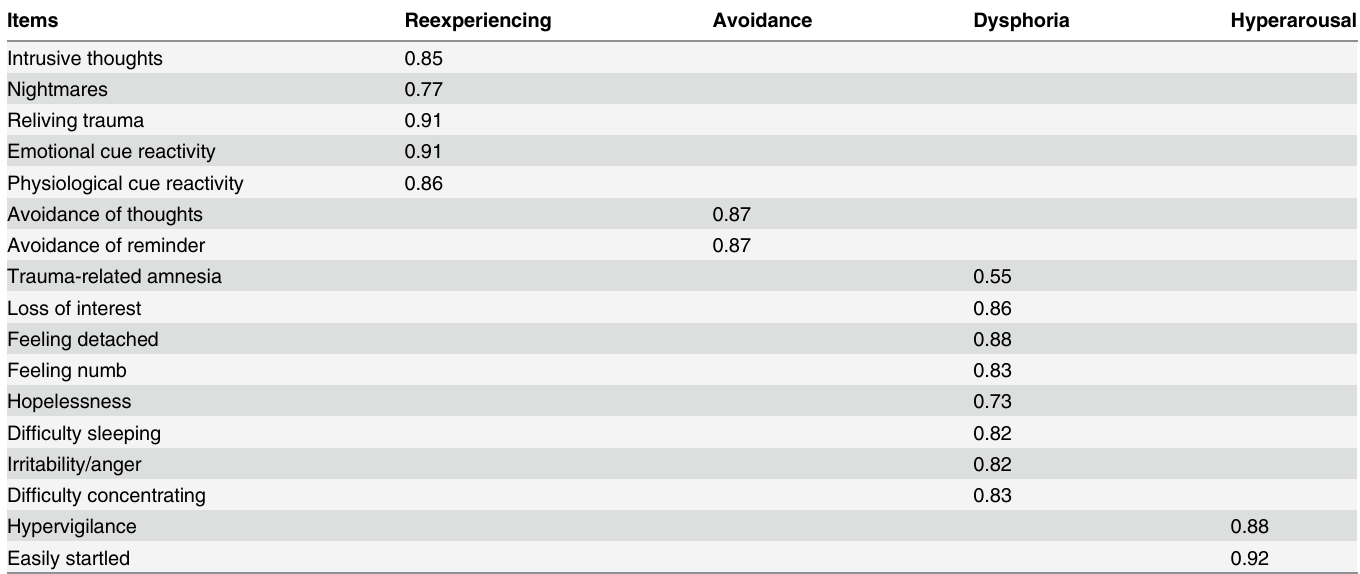
Table 2. Standardized Factor Loadings for the PTSD Dysphoria Model.